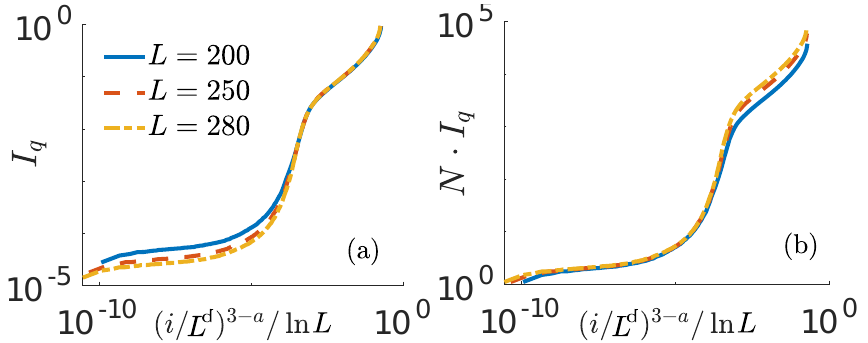
Figure 10: Energy-resolved inverse participation ratio sorted in increasing order versus renormalized state index (a) IPR itself showing collapse at the localized states and (b) IPR renormalized to the system size N = L d showing the collapse for ergodic states. The disorder strength for a = 1, β = 0.3 is W = 20. Finite size data is represented for L = 200 (solid blue), 250 (dashed red), and 280 (dash-dotted yellow) with the corresponding number of disorder realizations 100, 80, and 50,